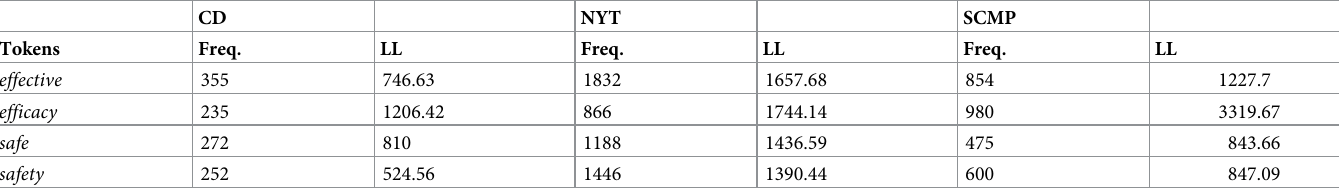
Table 1. The occurrences of four related tokens in the three corpora.